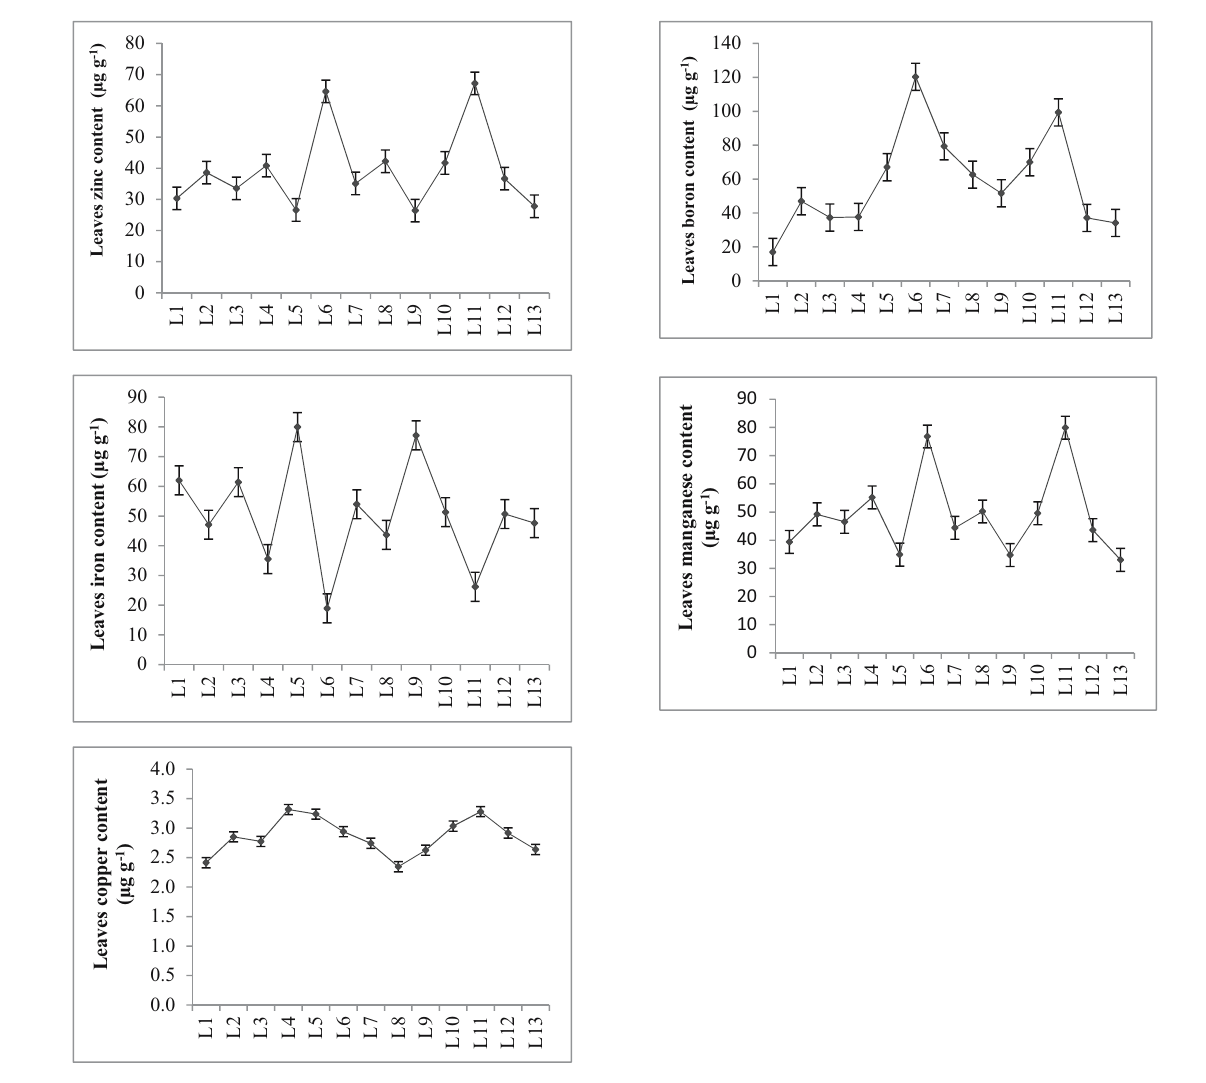
Figure 3: Micronutrients concentration in leaves of mango trees from di ff erent locations of Multan